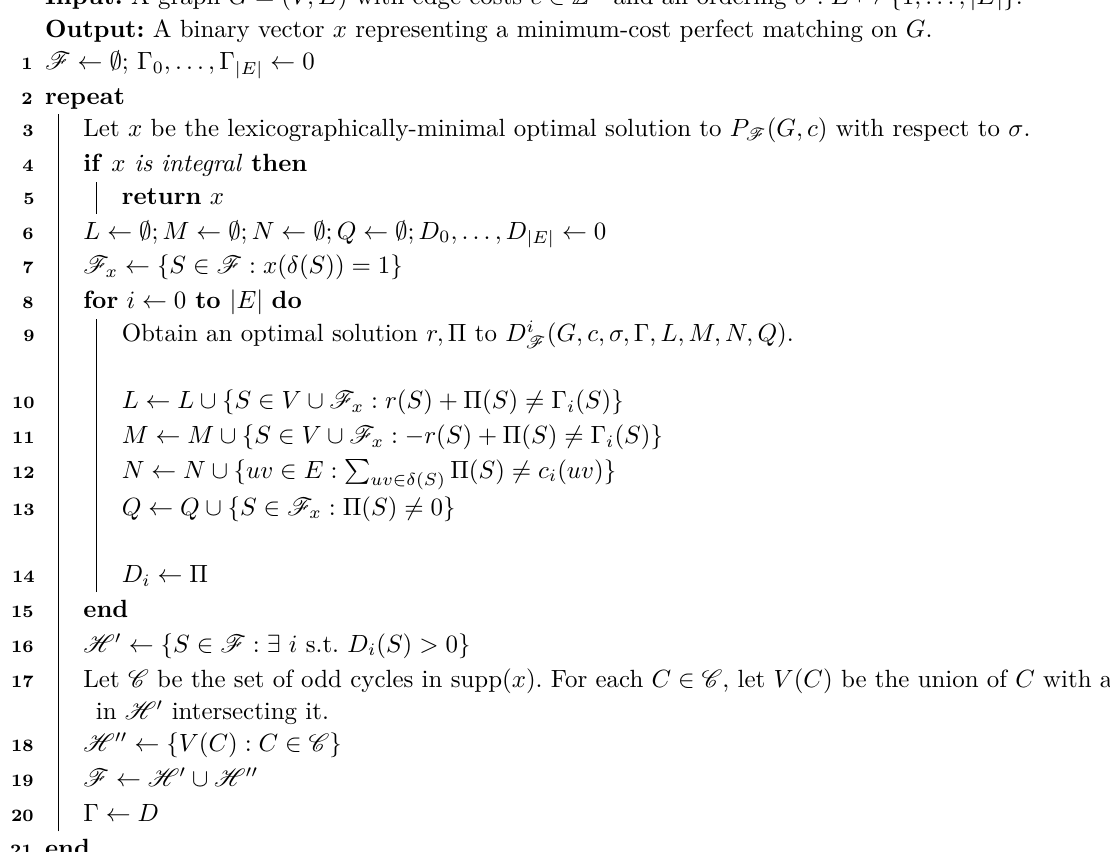
Algorithm 4: Unperturbed C-P-Matching